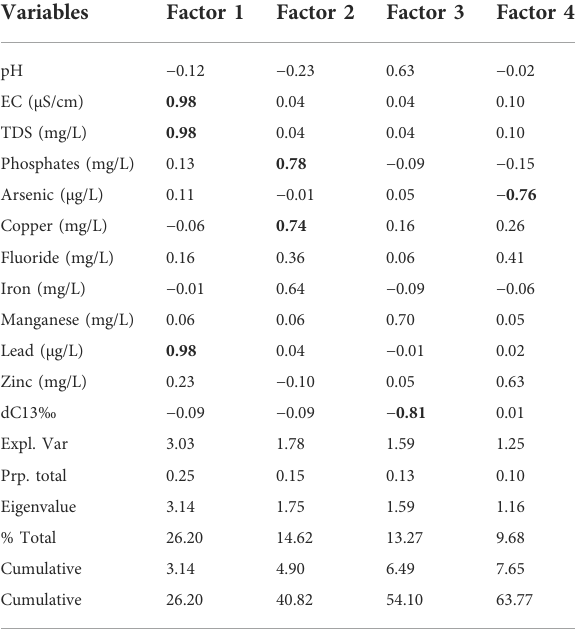
TABLE 4Factor Analysis ofheavy metals and stablecarbonisotopes in groundwater of the “ twin cities. ”